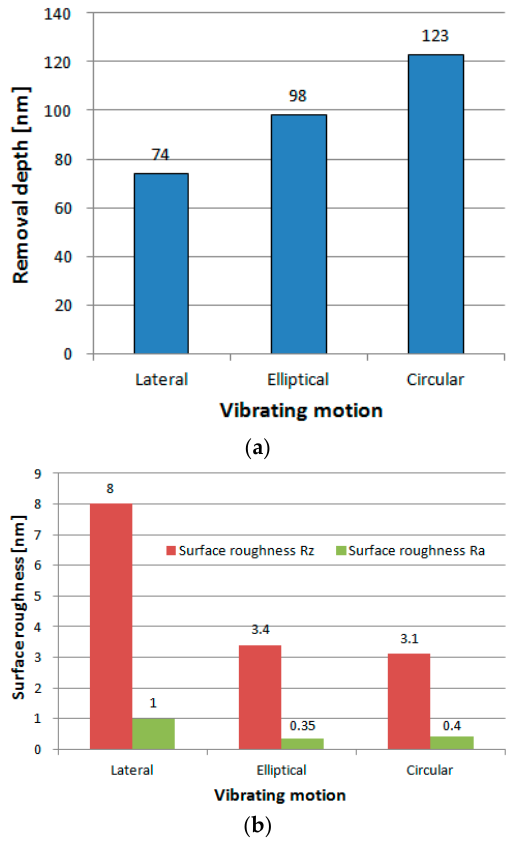
Figure 6. Effects of vibrating motions on ( a ) material removal and ( b ) surface roughness.